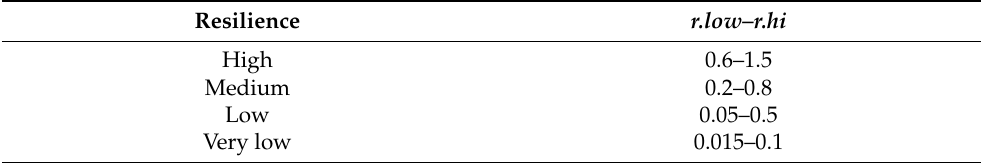
Table 3. Resilience and its corresponding r -value pair [30].